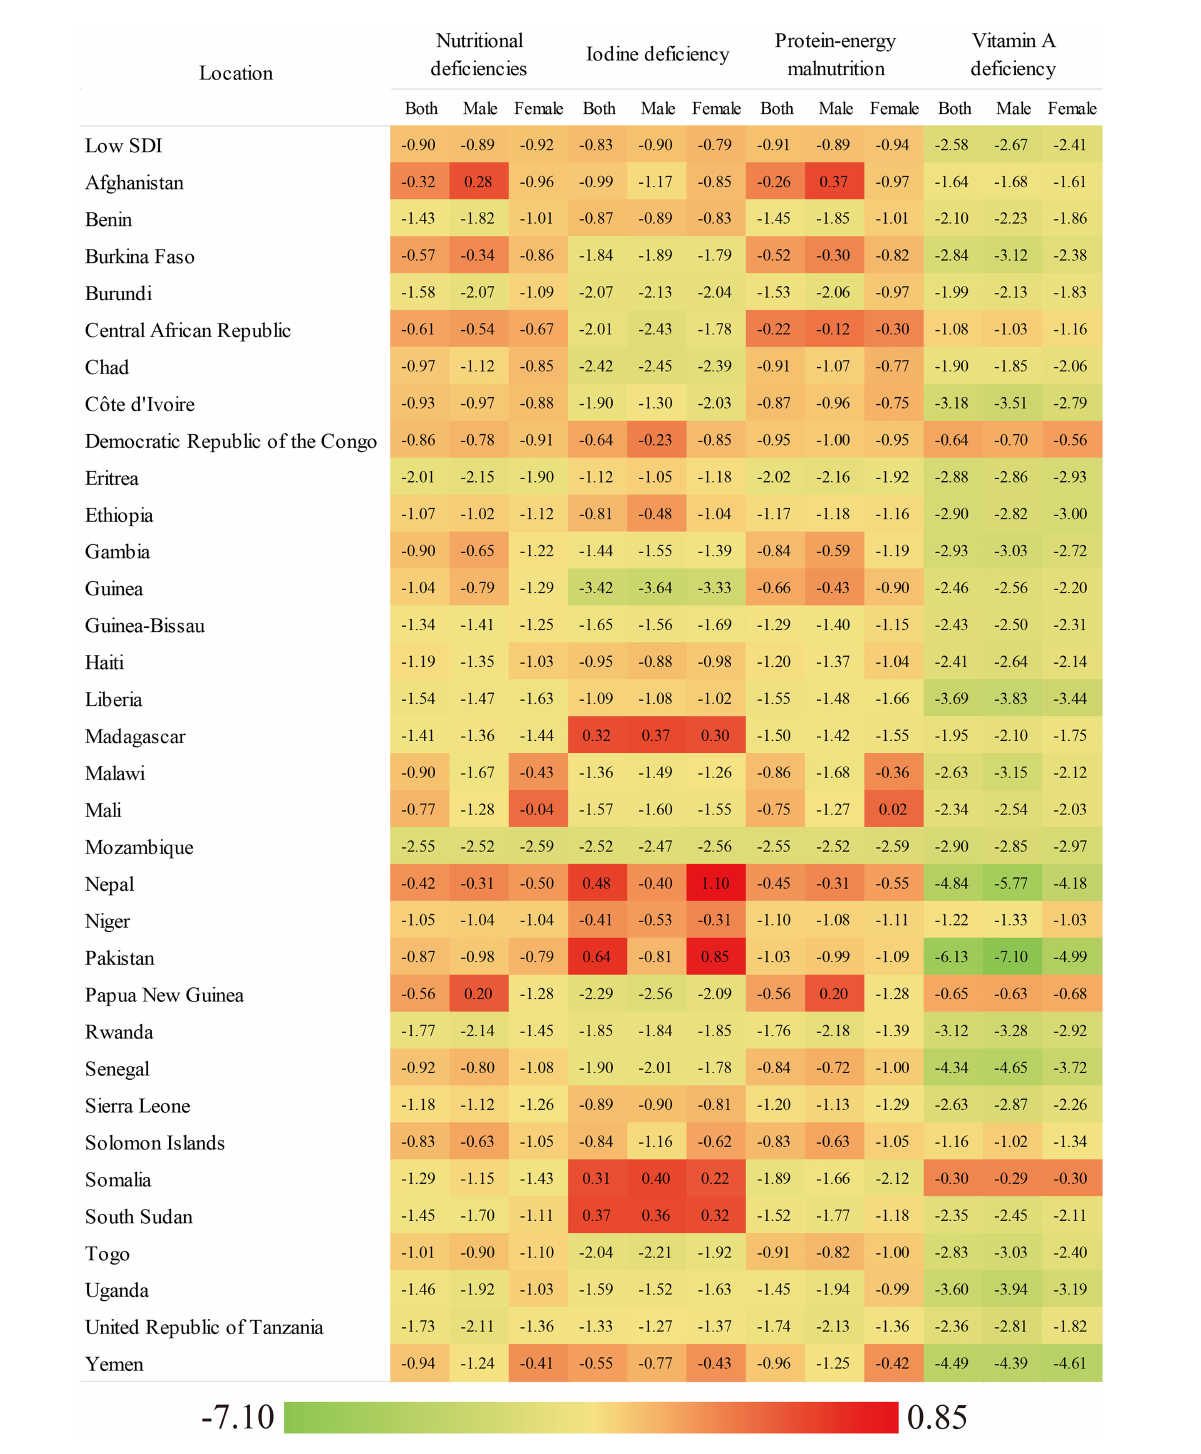
FIGURE1 The EAPC of age-standardized incidence rate of overall nutritional deficiency and its main subcategories from 1990 to 2019, by gender and country.